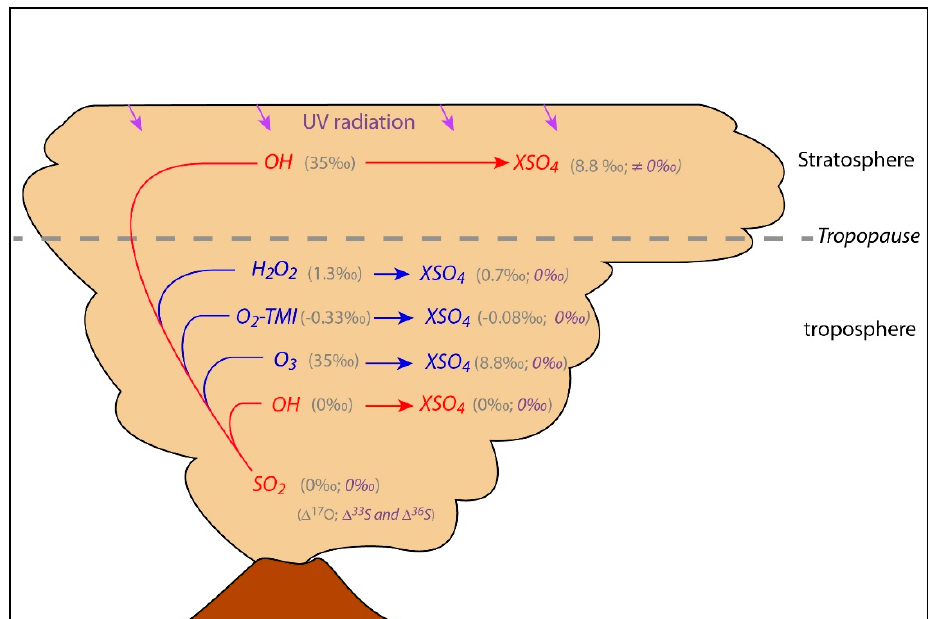
Figure 1. Volcanic SO 2 main oxidation channels in the troposphere and stratosphere (gas phase reactions in red and aqueous reactions in blue). X can be two monovalents or one bivalent cation (e.g., H + , K + , Na + , or Ca 2+ ). The average isotopic values of volcanic SO 2 , atmospheric oxidants and expected sulfates are indicated in grey values for Δ 17 O and purple for Δ 33 S and Δ 36 S. The detailed oxidation reactions are discussed in the text (Ch1, Ch2, Ch3 and Ch4). Note that sulfate oxygen atoms come partially from the atmospheric oxidants, at 25% from OH in Ch1, 50% from H 2 O 2 in Ch2, 25% from O 3 in for Ch3, and 25-50% from O 2 in Ch4 [19]. Using these proportions makes a theoretical estimation of sulfate Δ 17 O [20] possible. Δ 33 S and Δ 36 S ≠ 0 are generated mainly by SO 2 photolysis and photoexcitation by UV radiation [12,21,22], process that can most likely take place in the stratosphere above the O 3 layer, where UV radiations are not filtered. Note that in the troposphere Δ 33 S and Δ 36 S = 0 is expected but some mass dependent processes can generate small isotopic anomalies as discussed in the text (Section 3.2) and in Figure 3.